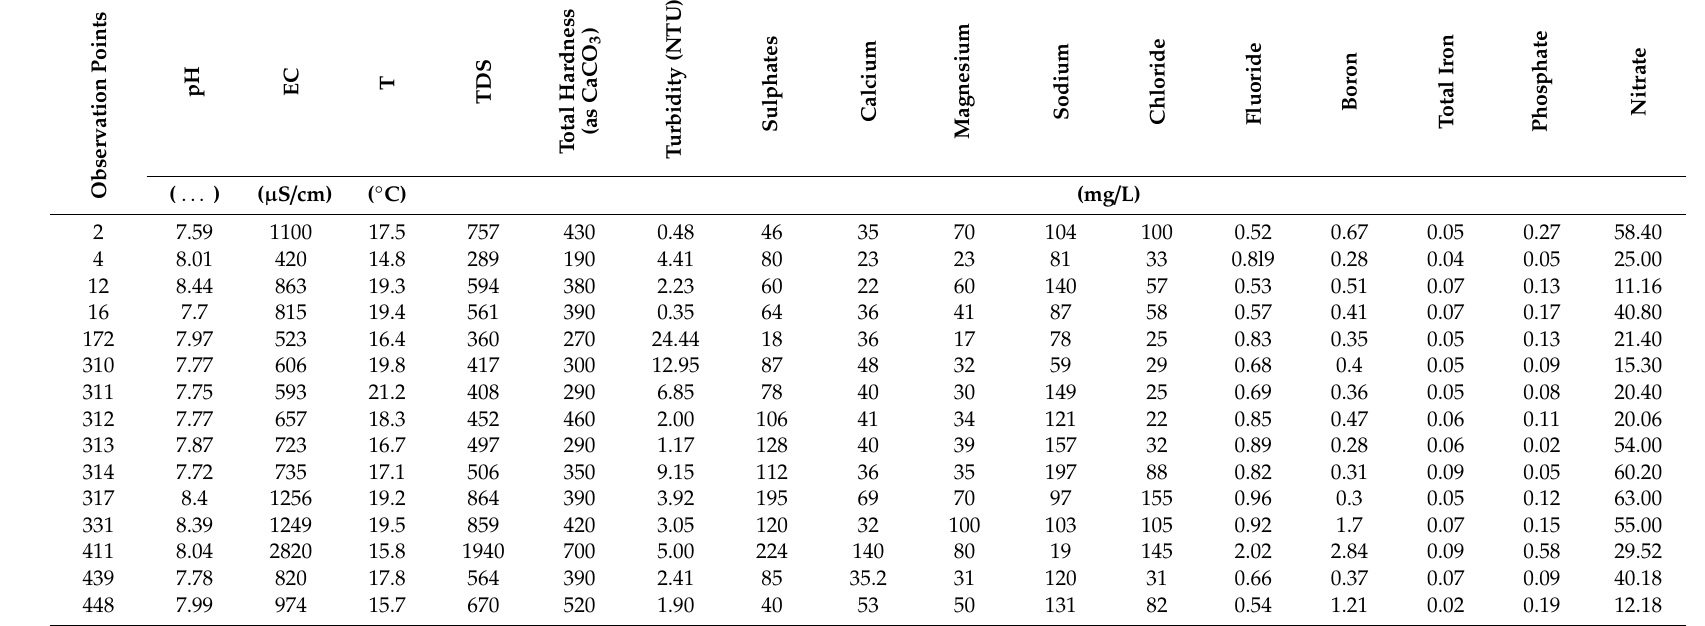
Table 7. The physicochemical parameters values in all observation